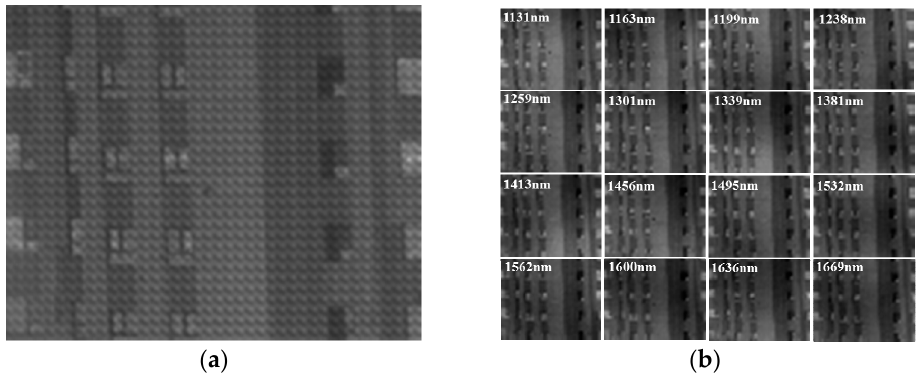
Figure 13. A raw image of monochromatic light with a wavelength of 1163 nm and its enlarged version.